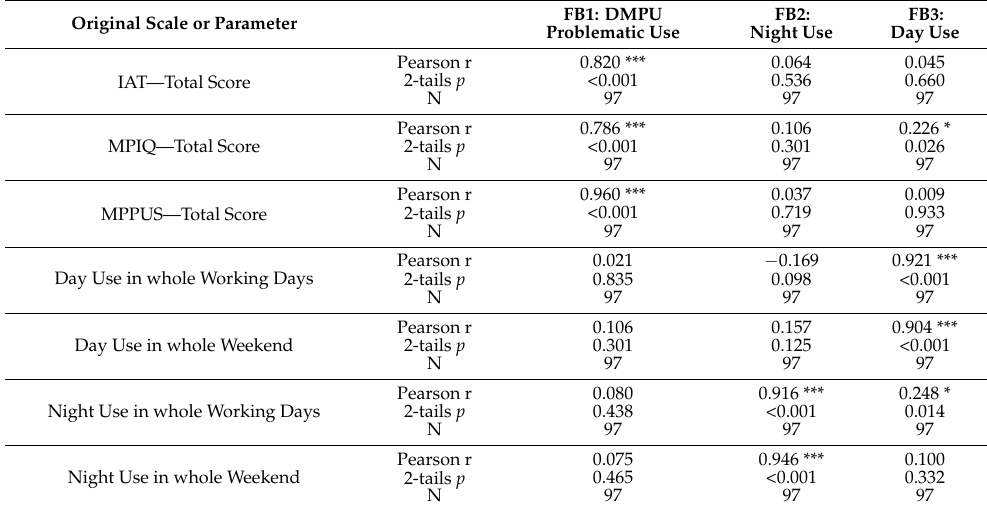
Table 10. Correlations between the extracted factors and the total scores of IAT, MMPIQ, MPPUS and the time schedule of mobile phone